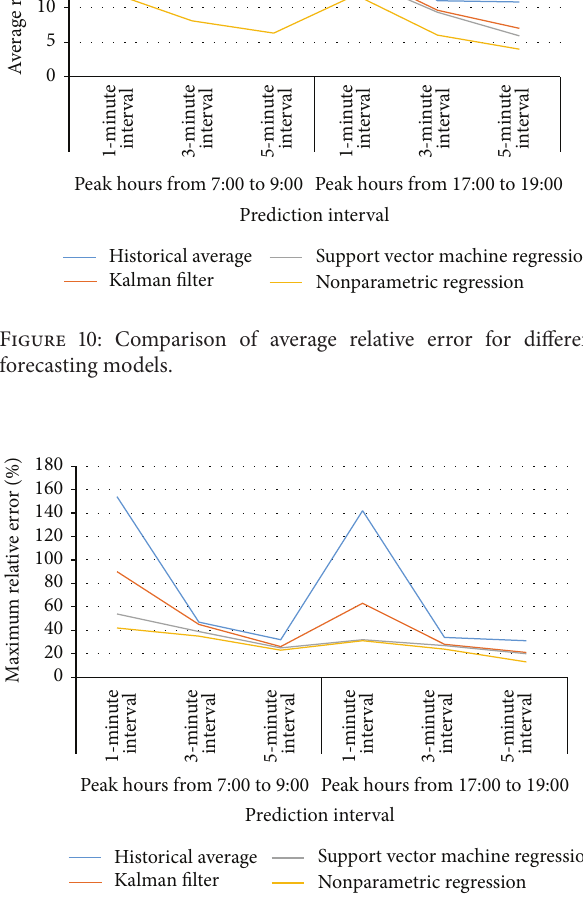
Figure 11: Comparison of maximum relative error for different forecasting models.